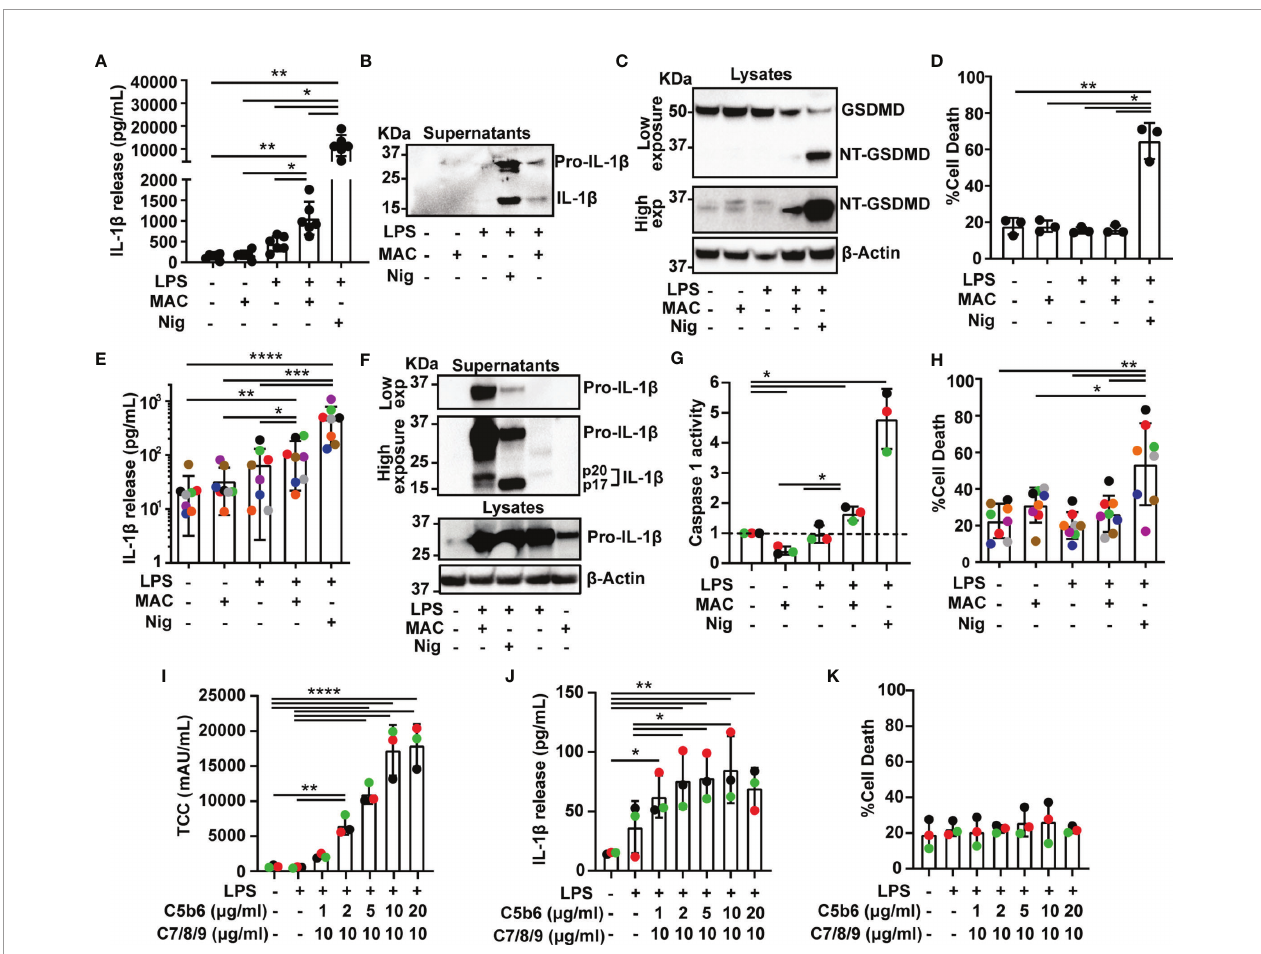
FIGURE 1 | The Membrane Attack Complex induces in fl ammasome activation in human macrophages. (A – K) THP1 cells (A – D) and human MDMs (E – K) were treated with vehicles or primed with 1 µg/mL LPS for 3 hrs followed by stimulation with 10 µM nigericin (Nig) for 45 mins or with 10 µg/mL anti-CD59 mAb, 10 µg/mL C5b6, unless otherwise speci fi ed, C7, C8 and C9 (MAC) for 3 hrs. (A, E, J) IL-1 b secretion was measured by ELISA. (B, F) IL-1 b cleavage was analyzed in supernatants by immunoblot. (C) GSDMD processing was analyzed in lysates by immunoblot. (D, H, K) LDH release was measured as a proxy for cell death. (F) Pro-IL-1 b production was analyzed in supernatants and cell lysates by immunoblot. (G) Caspase 1 activity was measured in cell supernatants and expressed as fold increase vs untreated cells. (I) TCC (MAC) amount in cell lysates was measured by ELISA. (A, D, E, G – K) Data is plotted as mean±SD and is representative of three (D, G, I – K) , six (A) , seven (E) or eight (H) independent experiments. (E, G – K) Each color represents a matched donor. (A, D) Each dot represents a repeat. (A, D, E, G – K) Statistical signi fi cance was measured by one-way ANOVA (A, D, G – K) or Friedman test (E) (*p < 0.05, **p < 0.01, ***p < 0.001, ****p < 0.0001). (B , C , F) Blots are representative of two independent experiments with similar